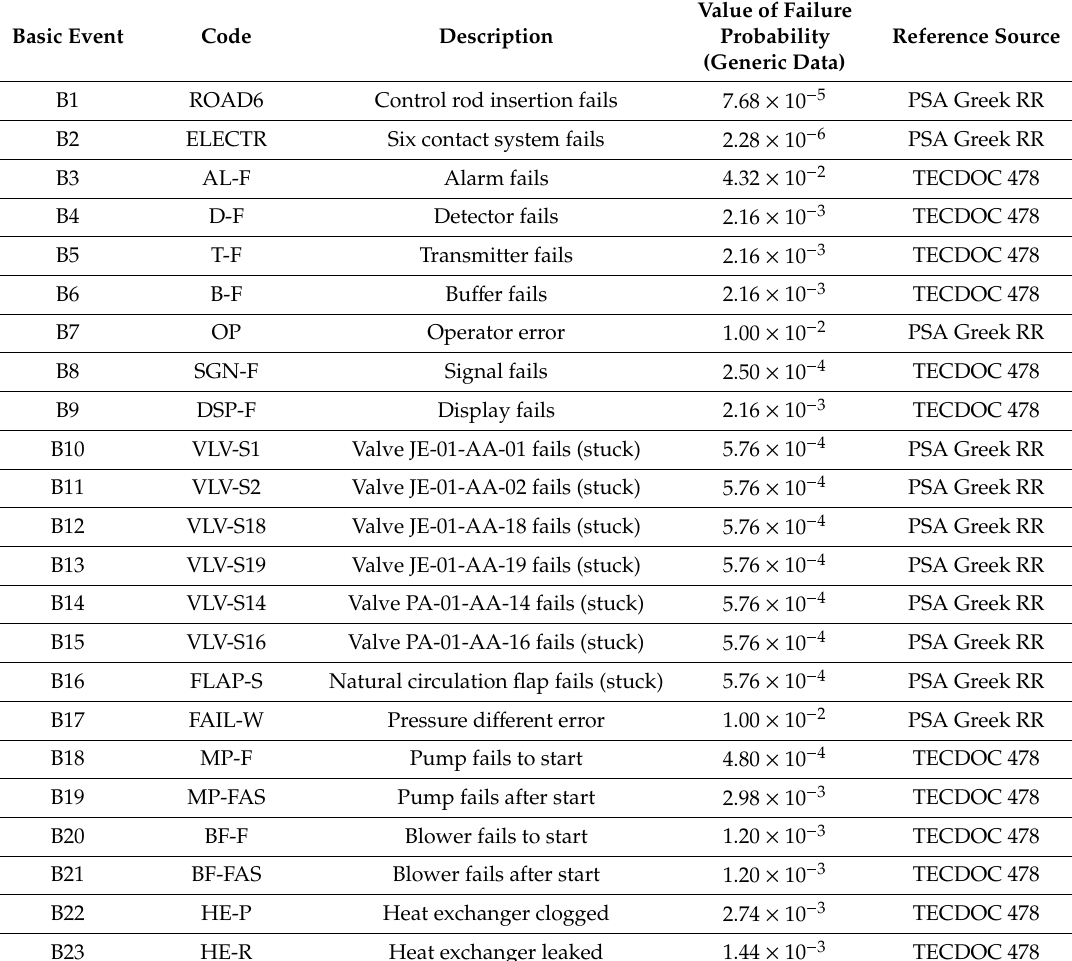
Table 3. Basic events data of the RSG-GAS primary cooling system